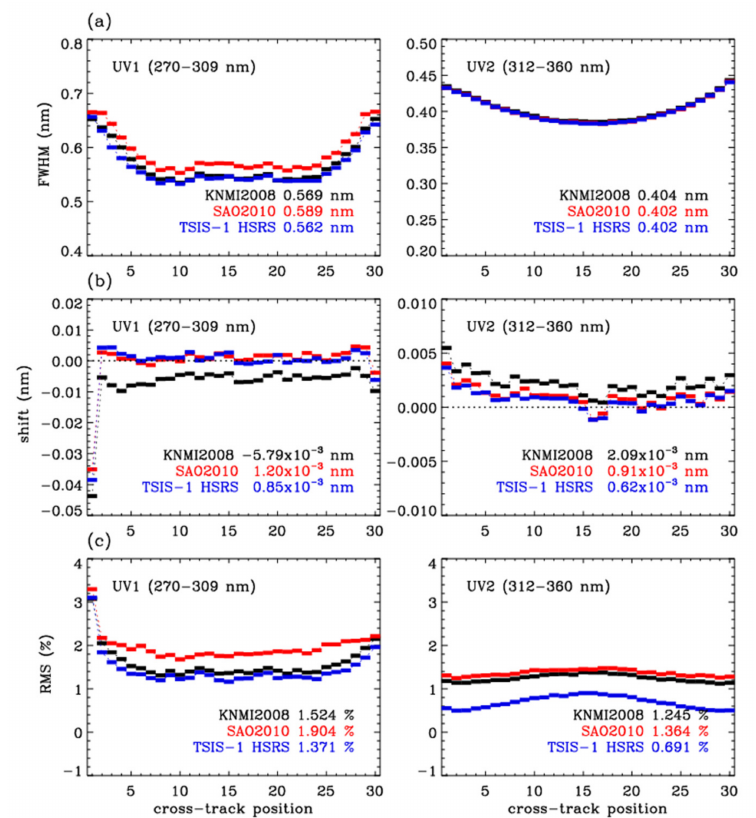
Figure 2. Impact of using different solar reference datasets on the spectral fitting of OMI irradiances with respect to ( a ) FWHMs fitted as Gaussian functions and ( b ) wavelength shifts as well as ( c ) RMS of fitting residuals. This experiment was performed for the monthly mean irradiances of daily OMI observations (July 2006) as a function of the cross-track positions over the UV1 (left) and UV2 (right) bands, respectively. The legend represents the average values of the fitting variables over the cross-track